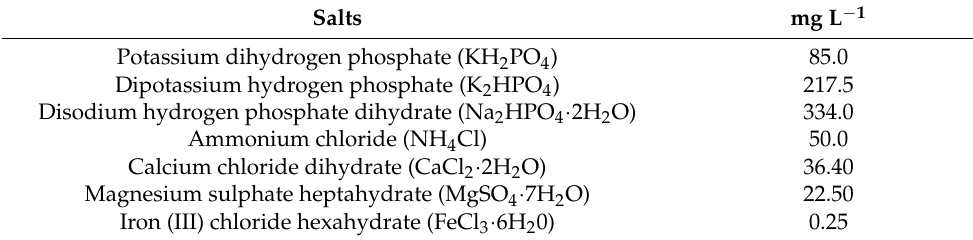
Table A1. Constituents of mineral salts solution used to adjust soil moisture [28].